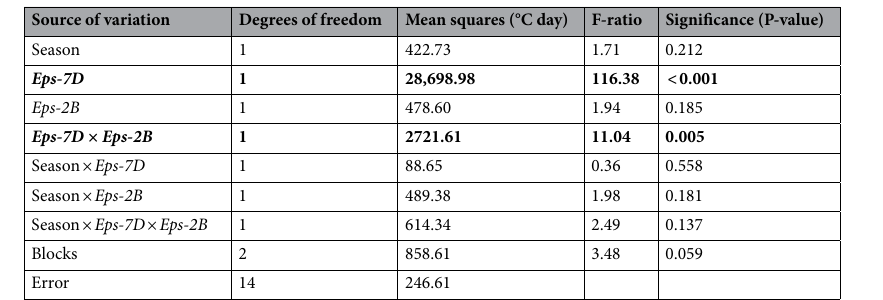
Table 3. ANOVA for time to anthesis. Factors that significantly affected this trait are in bold.